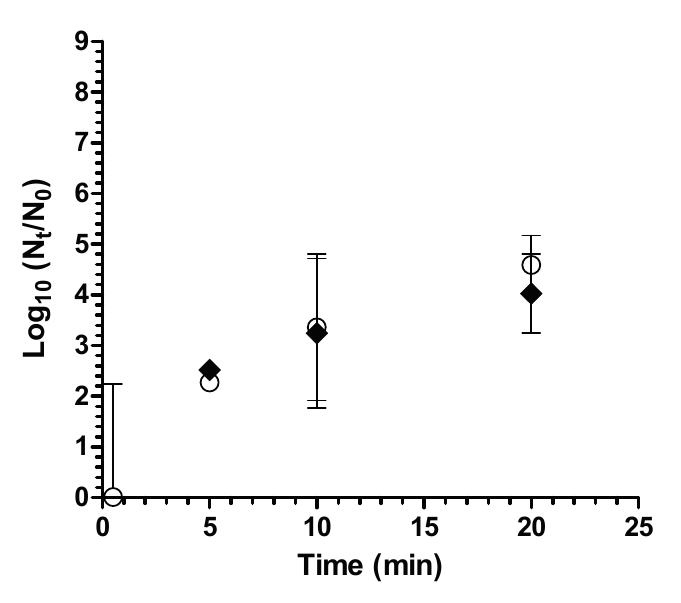
Figure 2. Reduction of A. hydrophila in natural surface water (B, n = 2 experiments) (white circles = bacterial reduction; black diamonds = free chlorine residual; bars = 95% confidence interval).